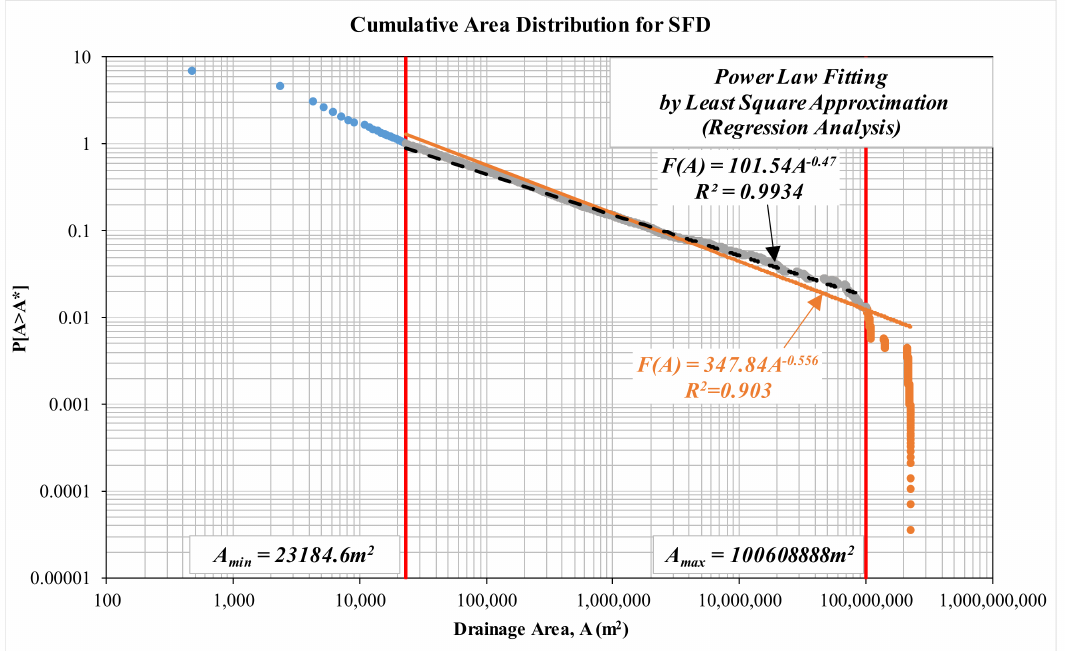
Figure 5. Power law distribution of the drainage area by regression